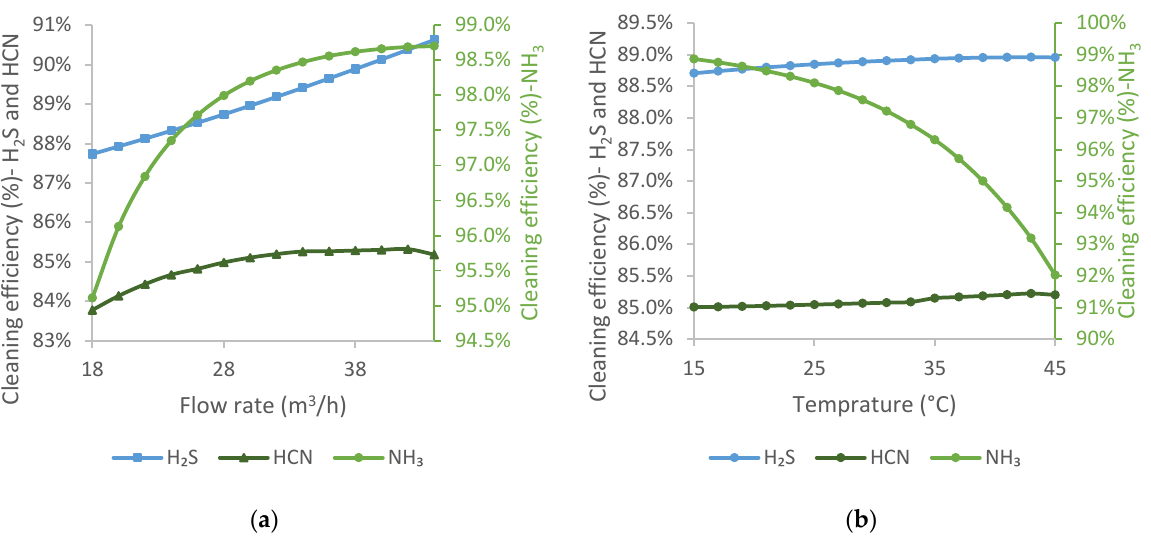
Flow rate (m 3 /h)